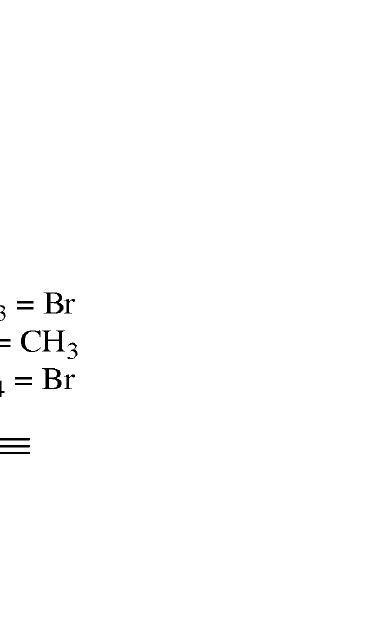
values of 90.7, 98.2, 89.6 and 91.7 m g/ml respectively. Compound 8c did not show any satisfactory results.